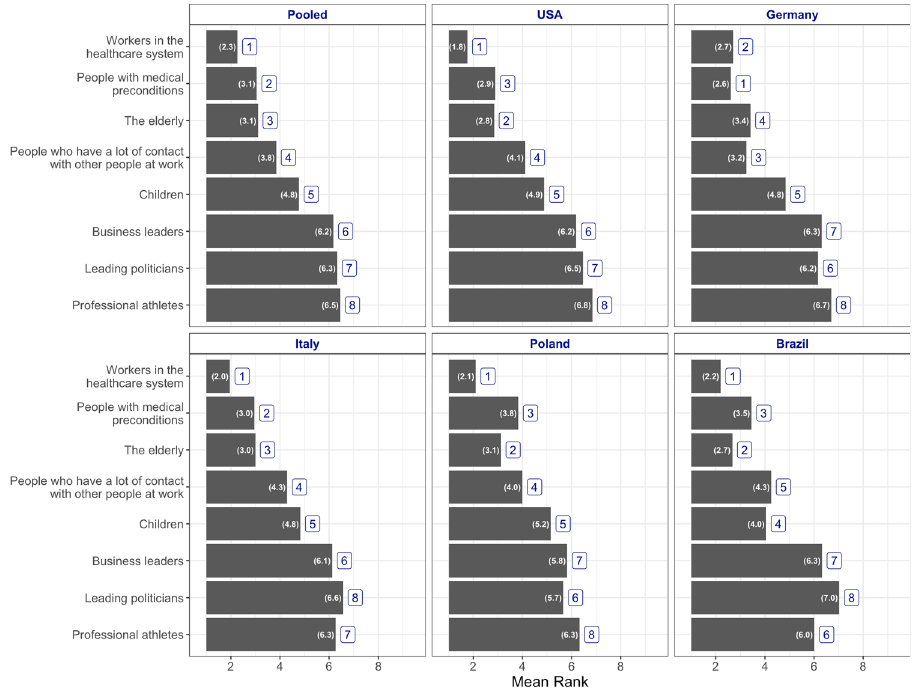
Fig. 2 Average ranks of groups by preferred priority. ( “ Which of the following groups should get vaccinated sooner, which later? ” ). Note: numbers inside the bar represent mean rank. Numbers outside the bar represent the absolute rank for each